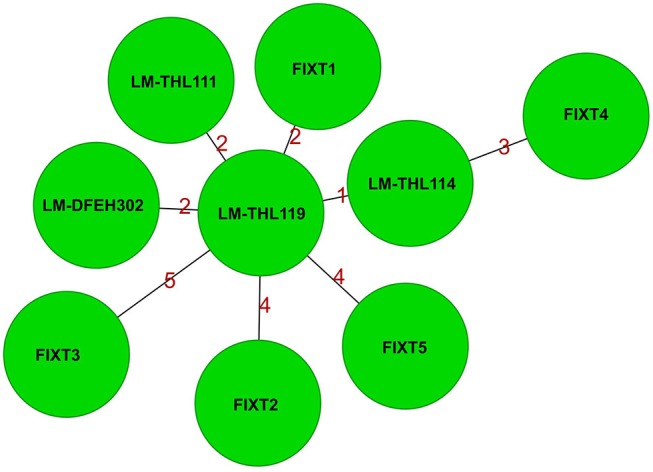
Minimum spanning tree based on 2,597 shared core genome and accessory genome targets of Listeria monocytogenes isolates. All isolates belong to seven-gene multilocus sequence type (ST) 124. All ST 124 isolates clustered together with less than seven allele differences (<0.3% difference). The cluster consisted of three isolates from three different patients (the index patient LM-THL119, LM-THL111 from year 2014, and LM-THL114 from year 2015), four food isolates from meatballs (LM-DFEH302, FIXT3, FIXT4, and FIXT5), and two environmental isolates from the meatball production plant (FIXT1 and FIXT2). Each node represents a single isolate and the values on the connecting lines illustrate the number of allele differences.